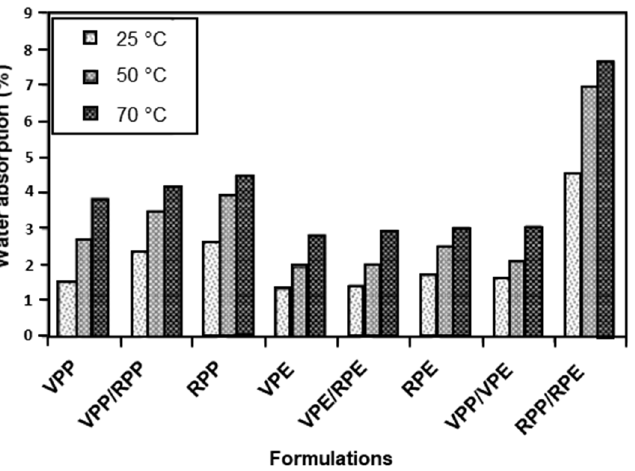
Figure 11. Water absorption of virgin and recycled plastic/wood flour composites after 2 h of immersion at three immersion temperatures: 25 °C, 50 °C, and 70 °C. Reproduced with permission [238].